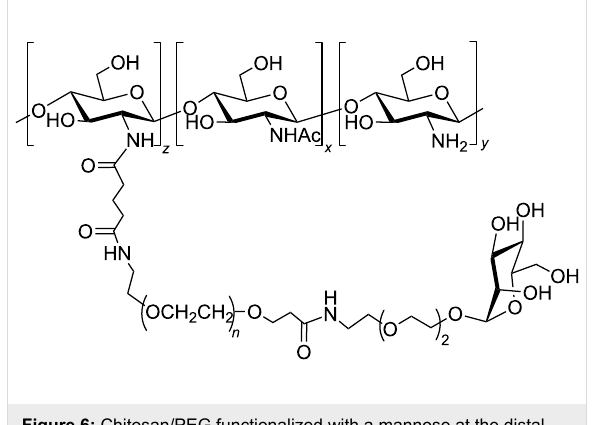
Figure 6: Chitosan/PEG functionalized with a mannose at the distal end, adapted from [62].